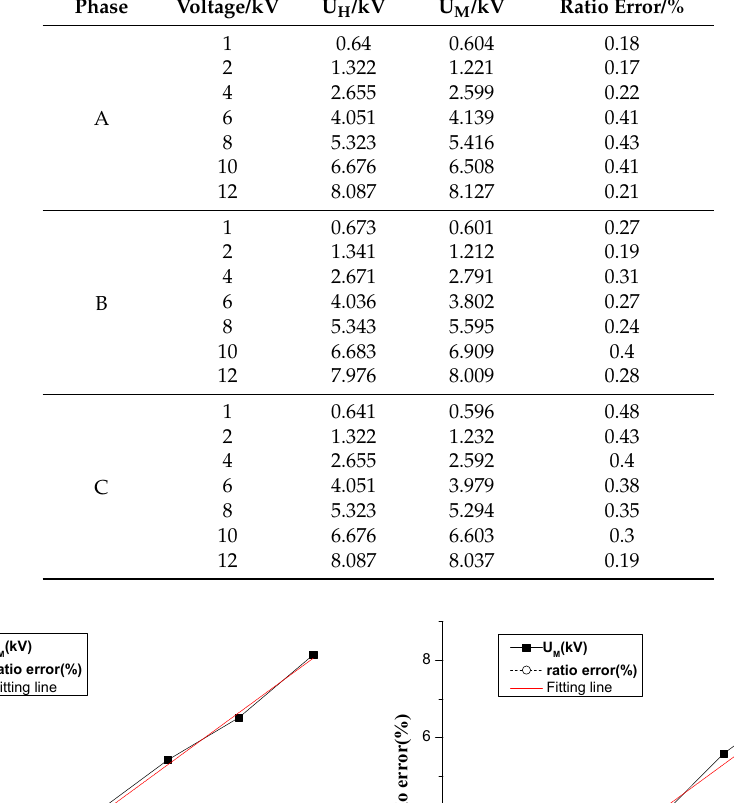
Table 4. Accuracy test of three-phase D-dot voltage transformer.